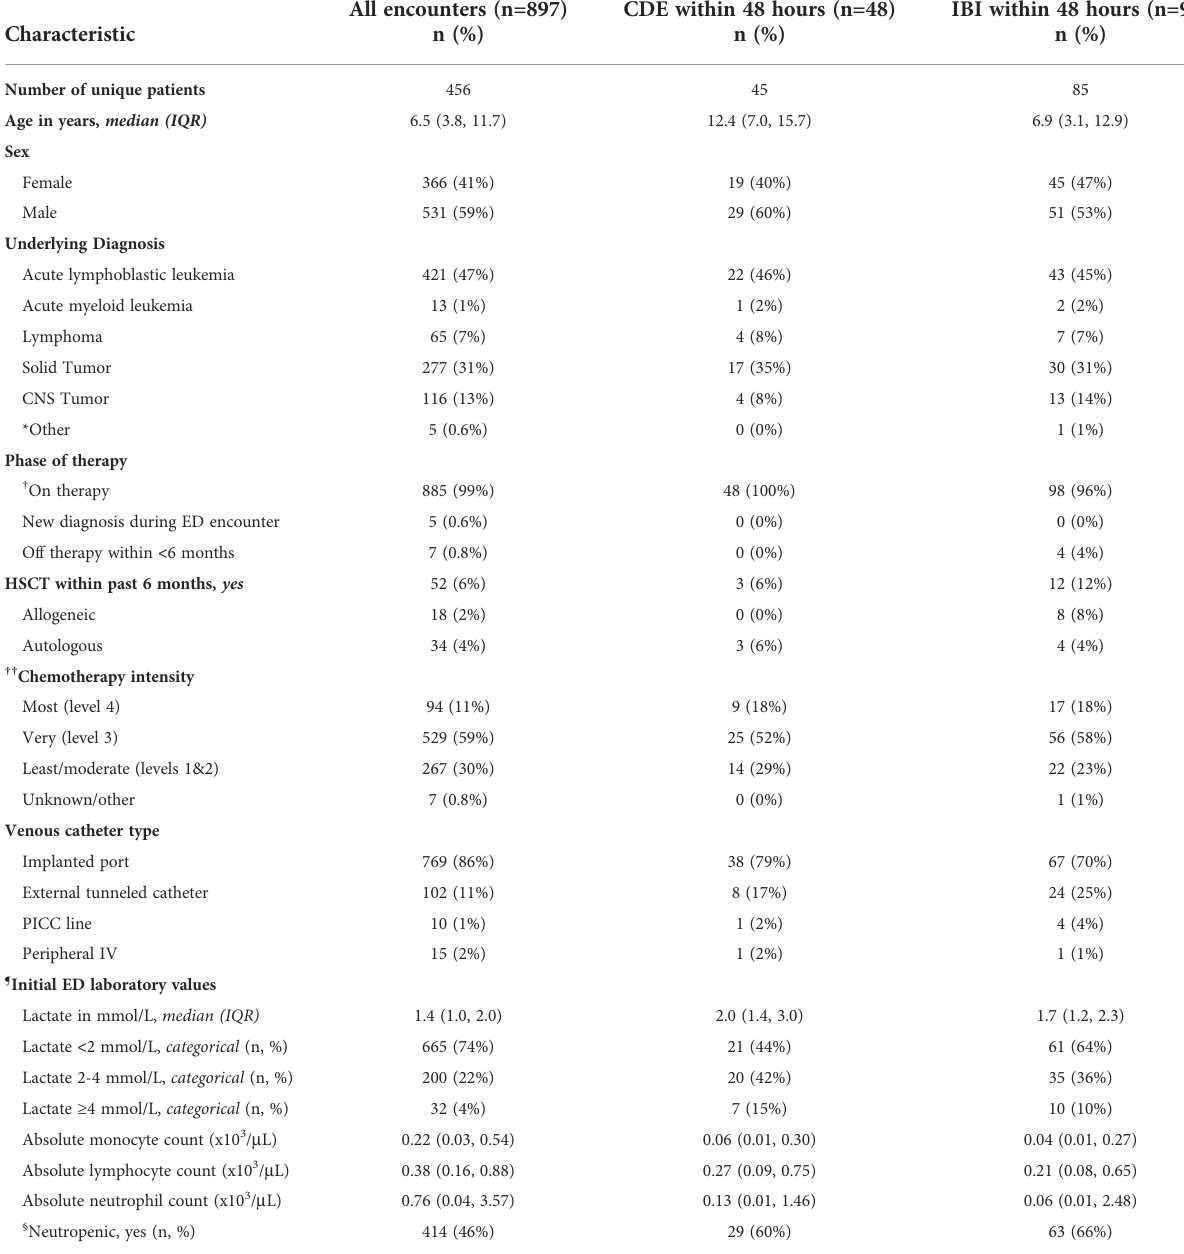
TABLE 1 Patient encounter characteristics and initial laboratory